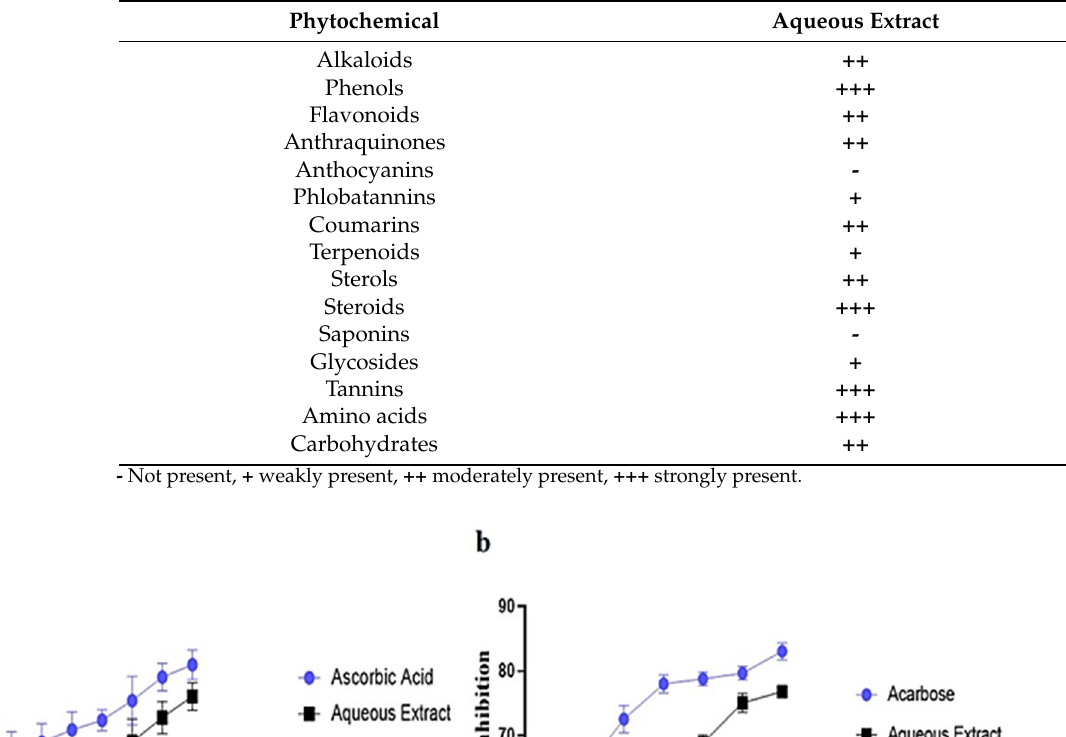
Table 1. Phytochemical screening of aqueous extract of Thymus serpyllum .